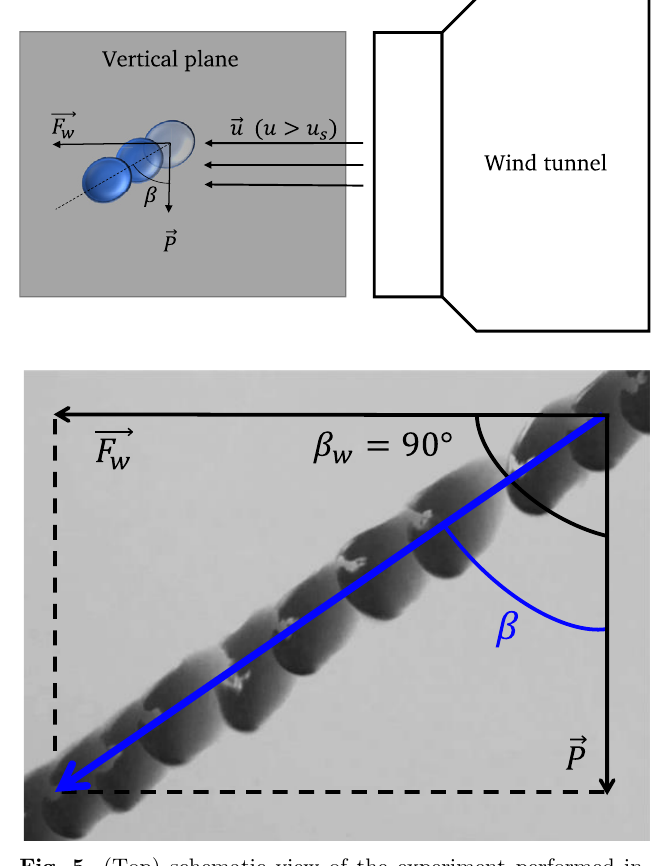
Fig. 5. (Top) schematic view of the experiment performed in order to measure the direction taken by a drop when dislodged by an horizontal wind. The support is maintained vertical. (Bottom) time-lapse photography of a drop in motion on a vertical plane under an horizontal wind. b w is the angle the wind makes with the vertical, while b is the angle which the sliding drop